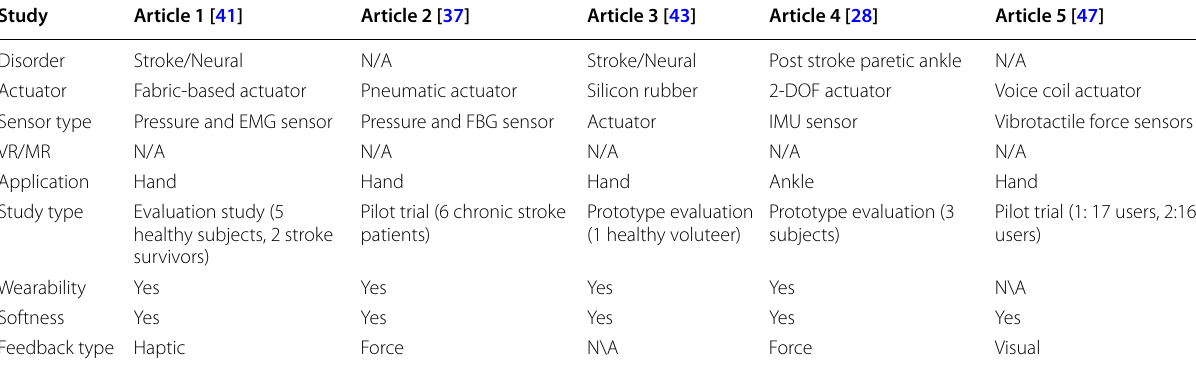
Table 4 Overview of 5 top research articles relevant to the current topic